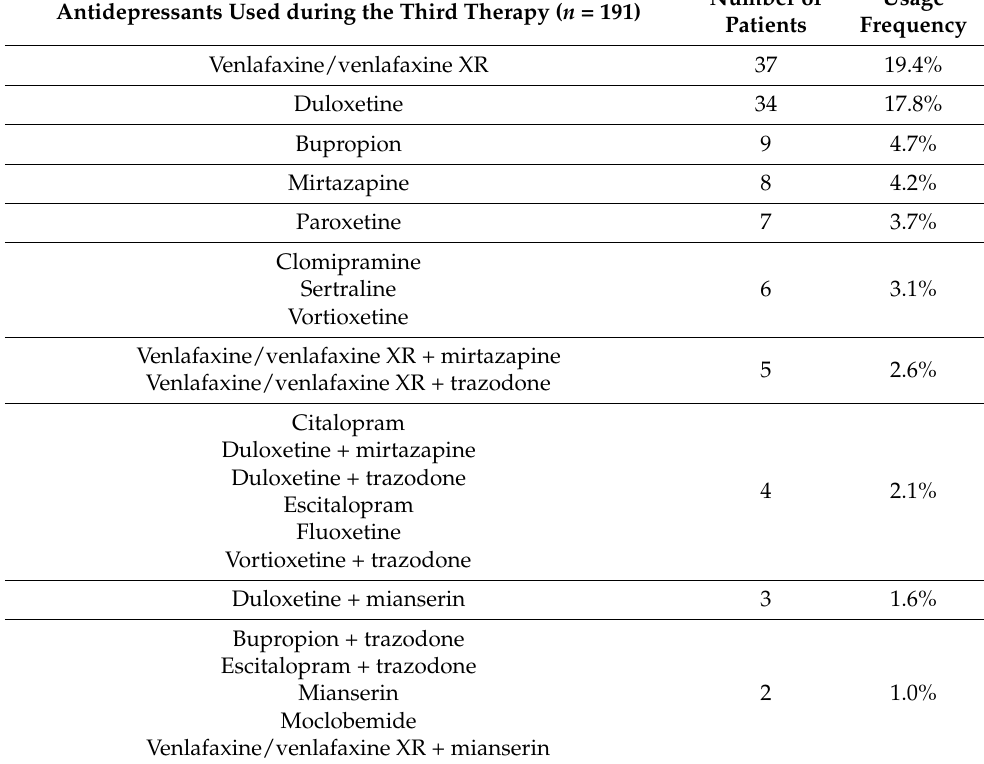
Table 7. Administered third-line antidepressant treatment during the current MDE (therapies with the same frequency of application are grouped